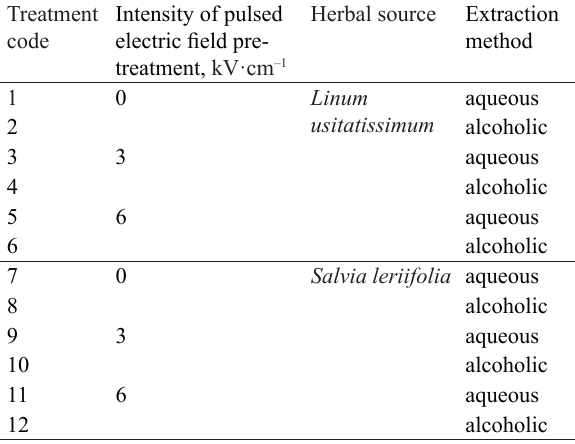
Extraction methodHerbal sourceIntensity of pulsed